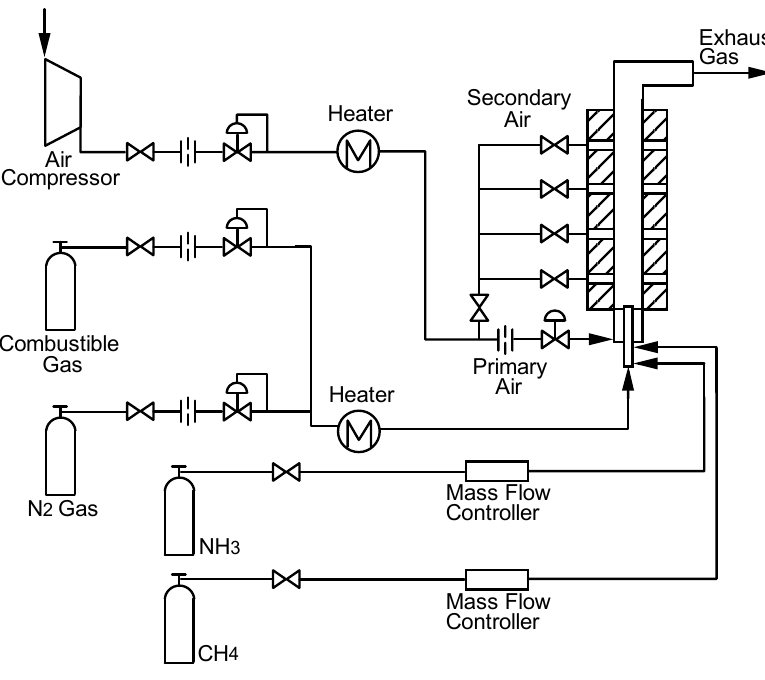
Figure 9. Schematic diagram of basic experimental